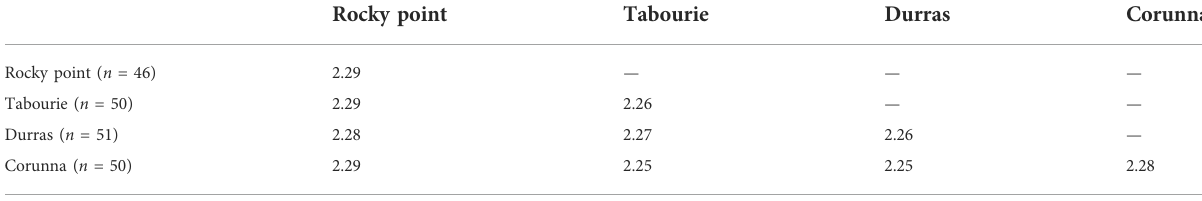
TABLE3Meanpercent mtCRDNAsequencedivergenceforwithinandbetweenfoureasternkingprawnpopulations,using samples collectedbefore stocking. The percent divergence, for a given data point in the table, is calculated as the divergence in nucleotide sequence between pairs of